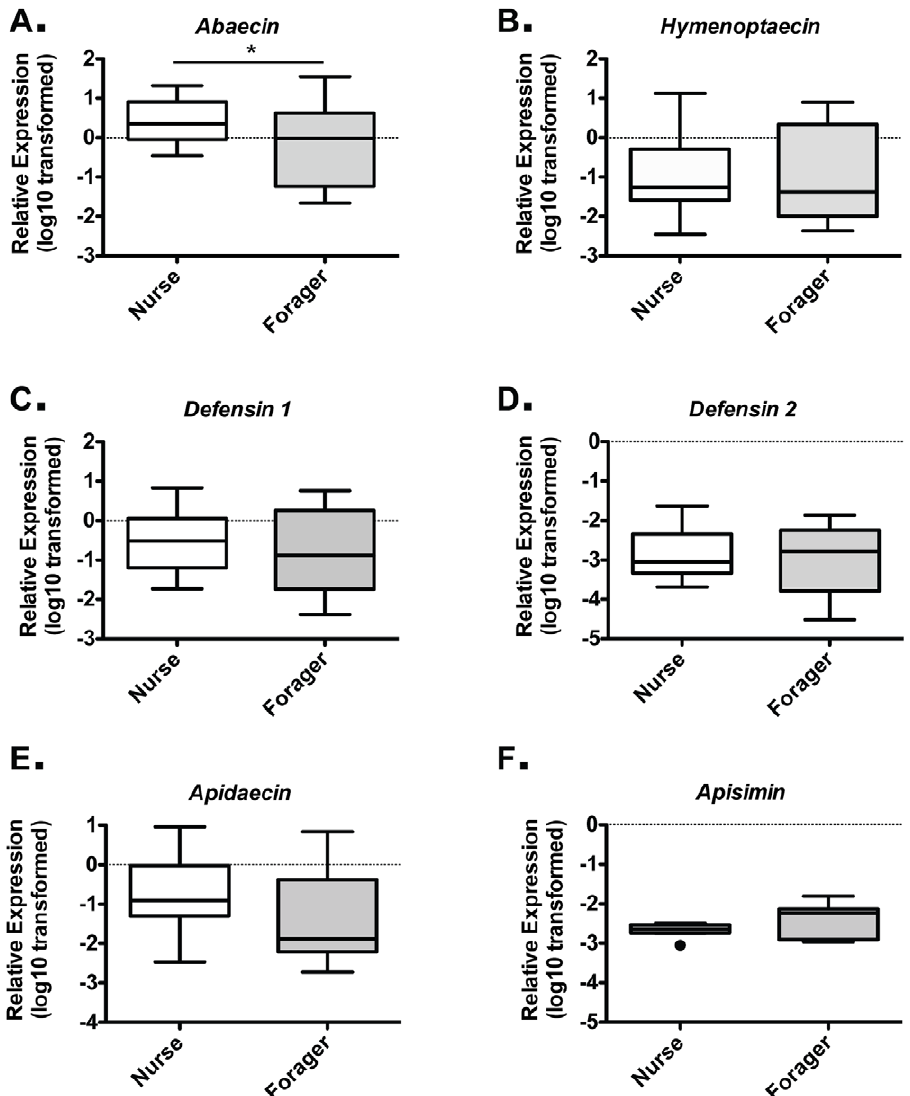
Figure 4. Nurse and forager AMP expression in fatbody tissue. Individual levels of the six honey bee AMPs relative to b -actin in abdominal tissue for Nurse and Foragers, as assessed by behavior and location cues, for Abaecin (A), Hymenoptaecin (B), Defensin 1 (C), Defensin 2 (D), Apidaecin (E), and Apisimin (F) from trials 3 and 4. Boxes show 1st and 3rd interquartile range with line denoting medians. Whiskers encompass 95% of the individuals. Outliers are denoted with filled